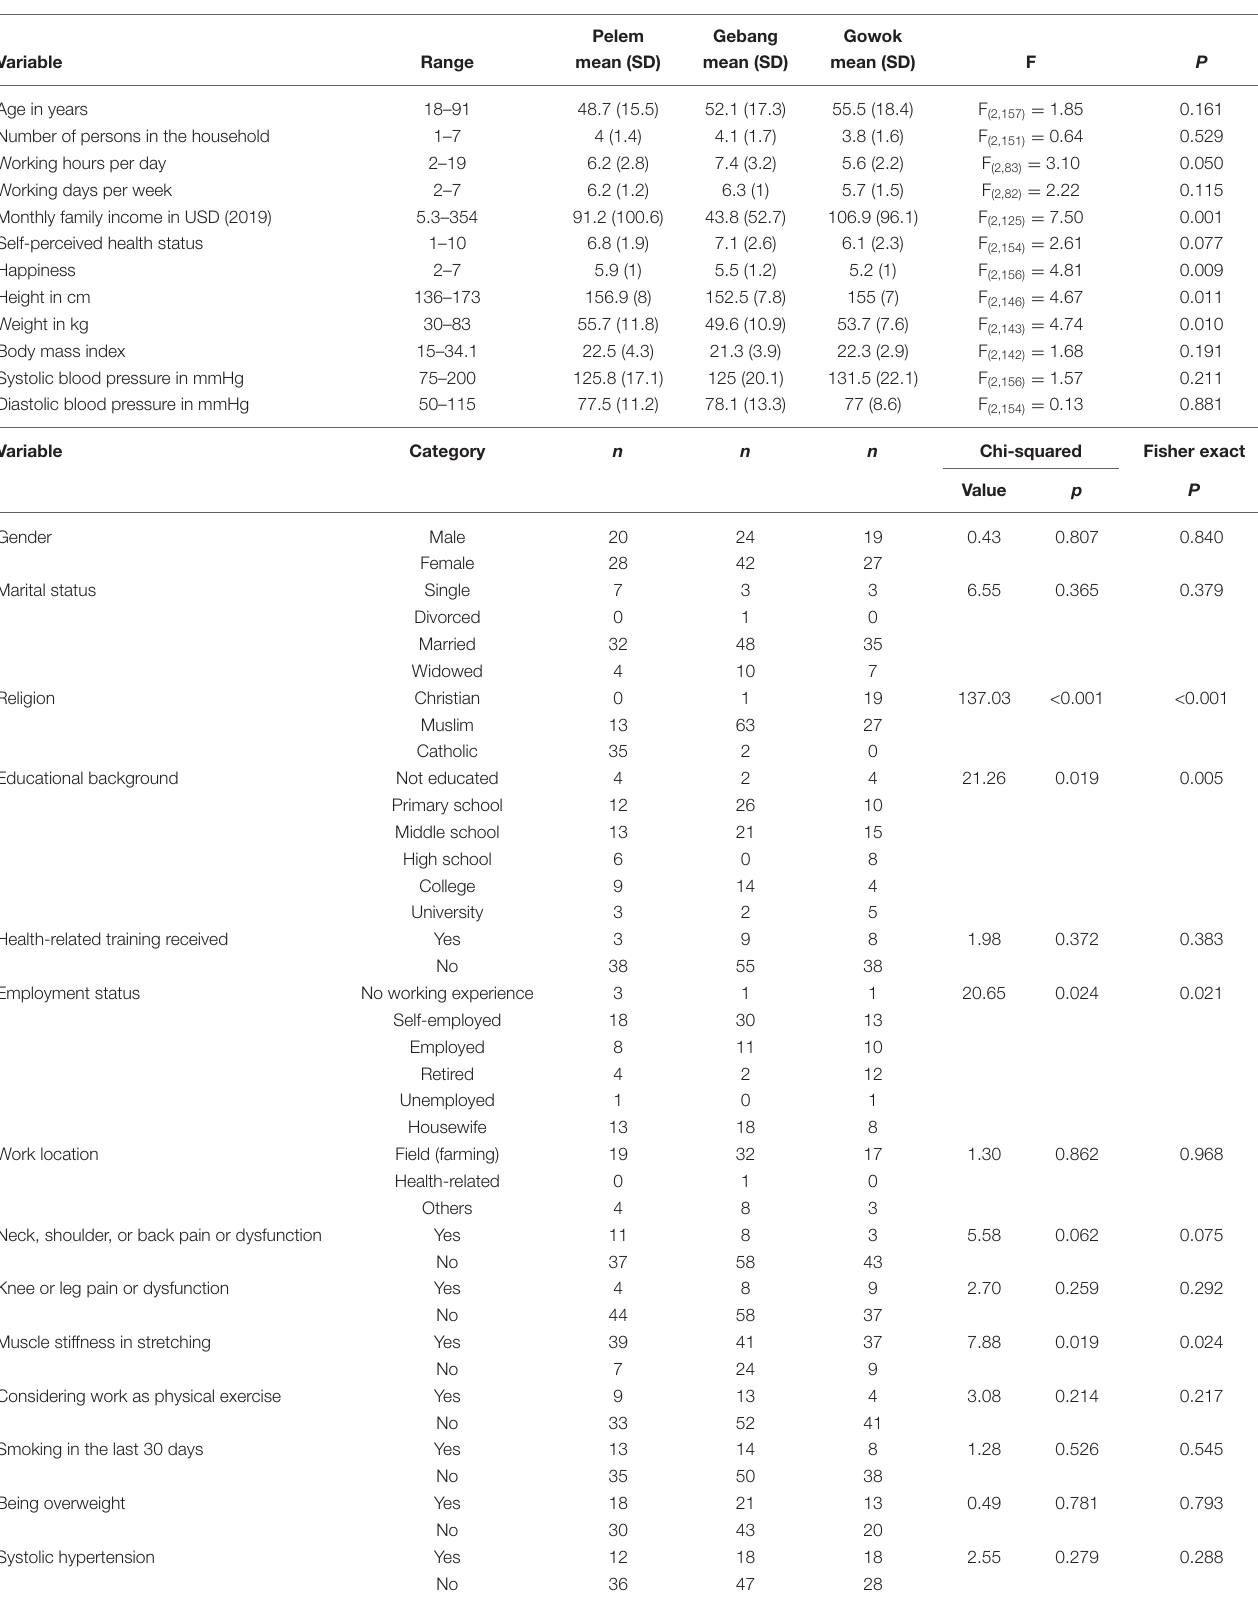
TABLE 1 | Baseline demographic characteristics of the participants.